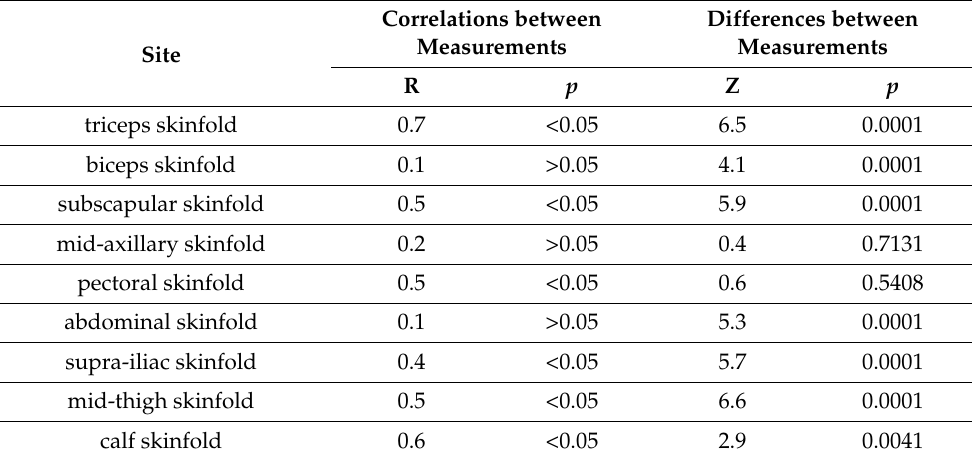
Table 2. Correlations between the measurements of the adipose tissue thickness obtained using the USG and the SC and the statistical significance of the differences between the measurement obtained from both methods ( n =